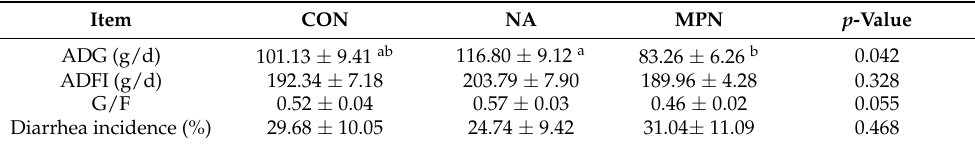
Table 3. Effect of niacin on growth performance in weaned piglets.